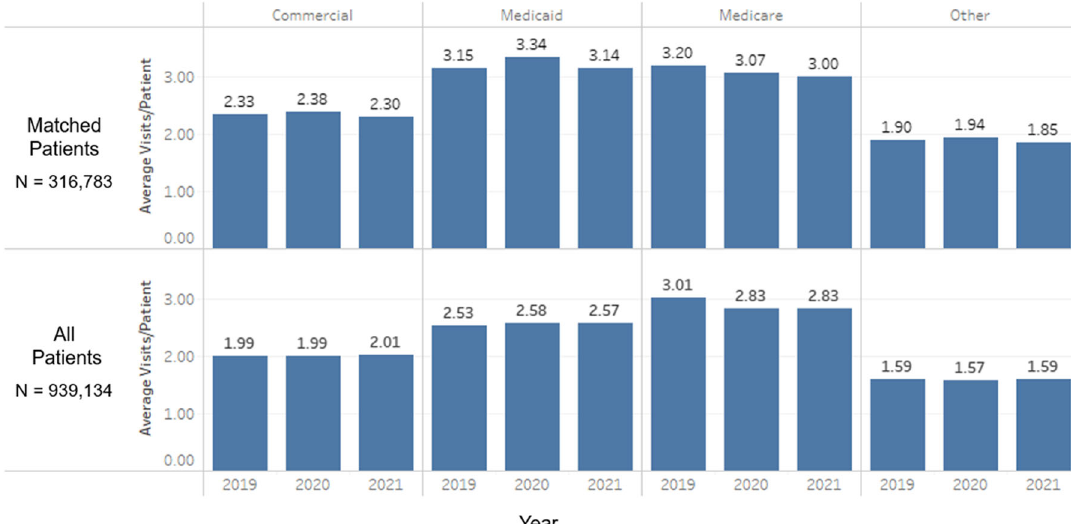
Fig. 1 Average number of primary care visits per patient remain stable from 2019 to 2021 across insurance groups. This fi gure shows the average number of encounters per year for all patients and matched patients by payor type. The number of patients in each insurance category are as follows: Commercial (621,490 total; 176,543 matched), Medicaid (74,853 total; 20,050 matched), Medicare (225,575 total; 128,137 matched), Other (42,306 total; 7291 matched).